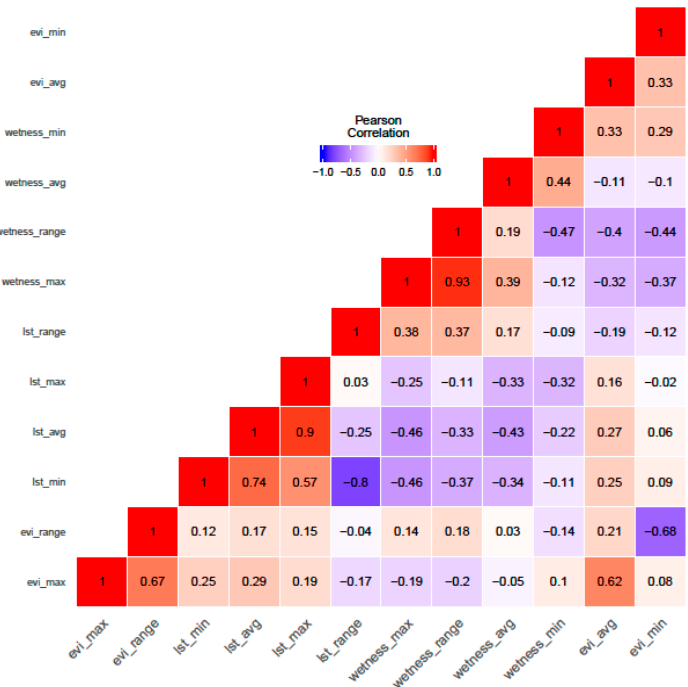
Figure A1. Heat map of Pearson’s correlation coefficient between the environmental variables initially considered (EVI—enhanced vegetation index; TCTwet—tasseled cap transformation (TCT)— water component; LST—surface temperature), taking into account the respective maximum values (max), minimum (min), average (avg), and range (range). The correlations were represented graphically using the “heatmap” function.